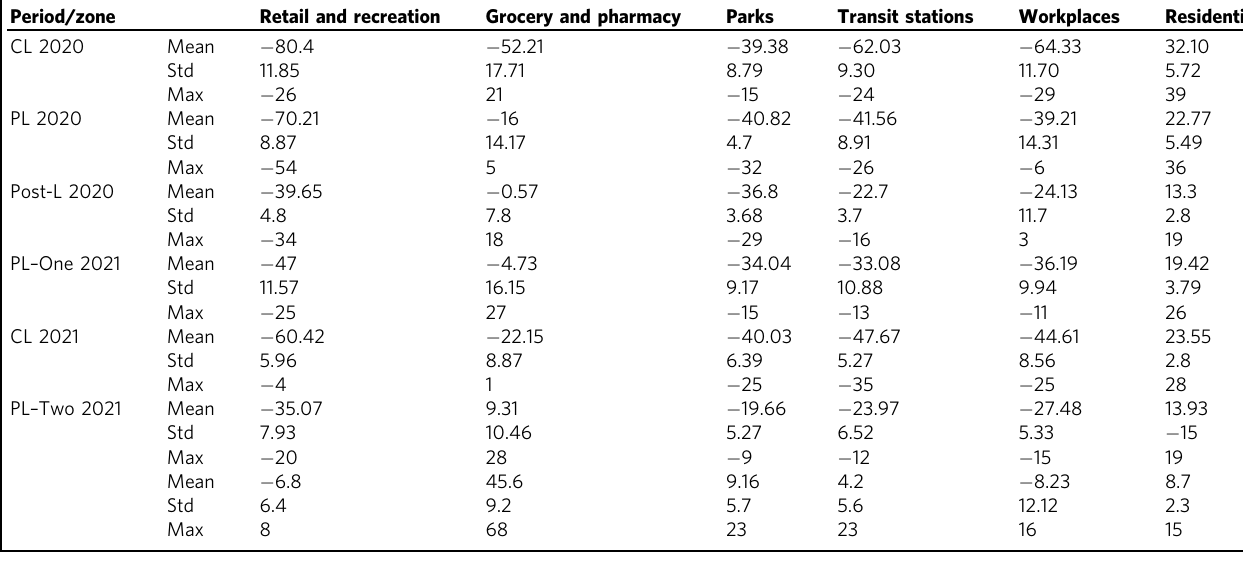
Table 2 Descriptive statistics of the changes in mobility (in %) from baseline during various lockdown phases in both waves in Tamil Nadu in the six spheres of activity.